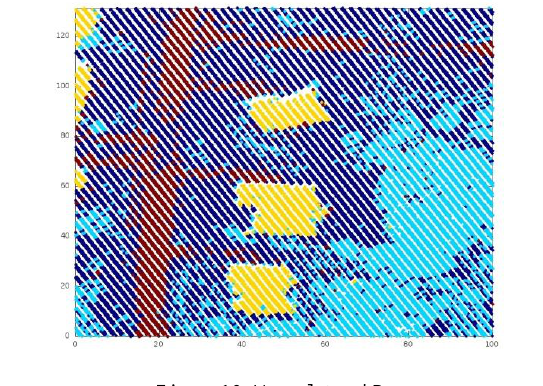
Figure 10: Wavelet and Bayes